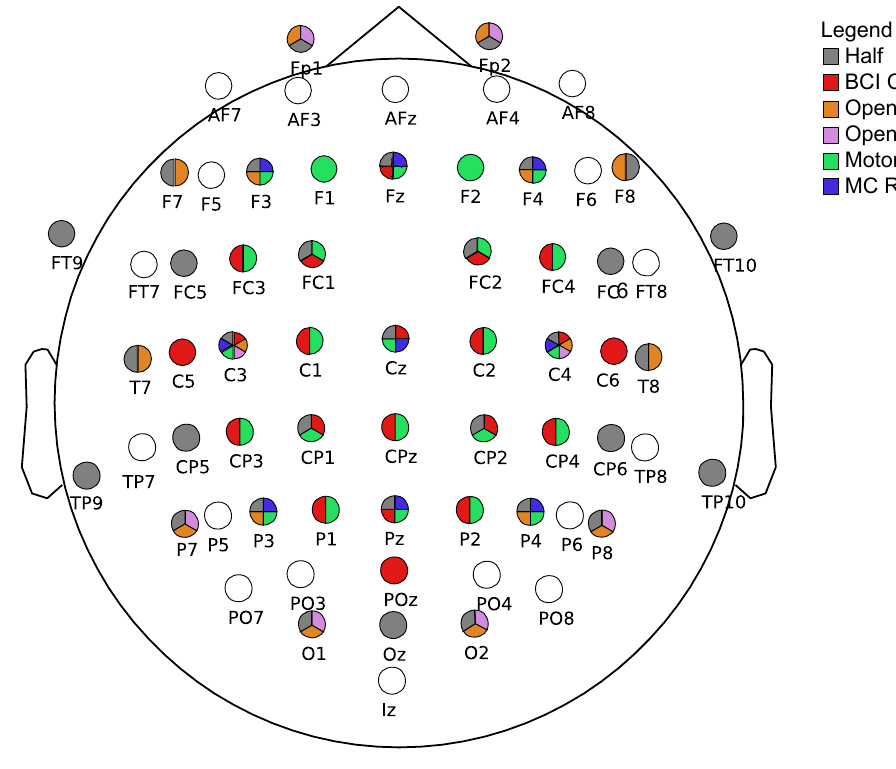
Figure 3. Locations of the sensors with colors indicating which subsets they belong to. Empty circles indicate that they are only used in the full